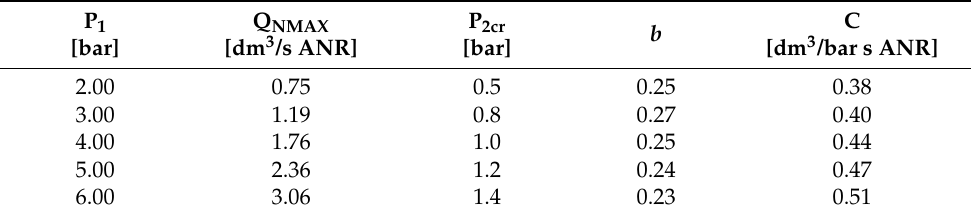
Table 3. Flow rate characteristics of the 2/2 valve in test at 20 ◦ C.